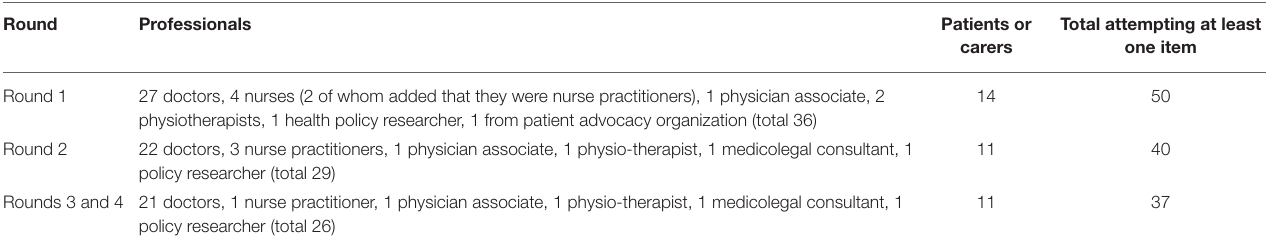
TABLE 1 | Sample for Delphi study of underpinning principles.